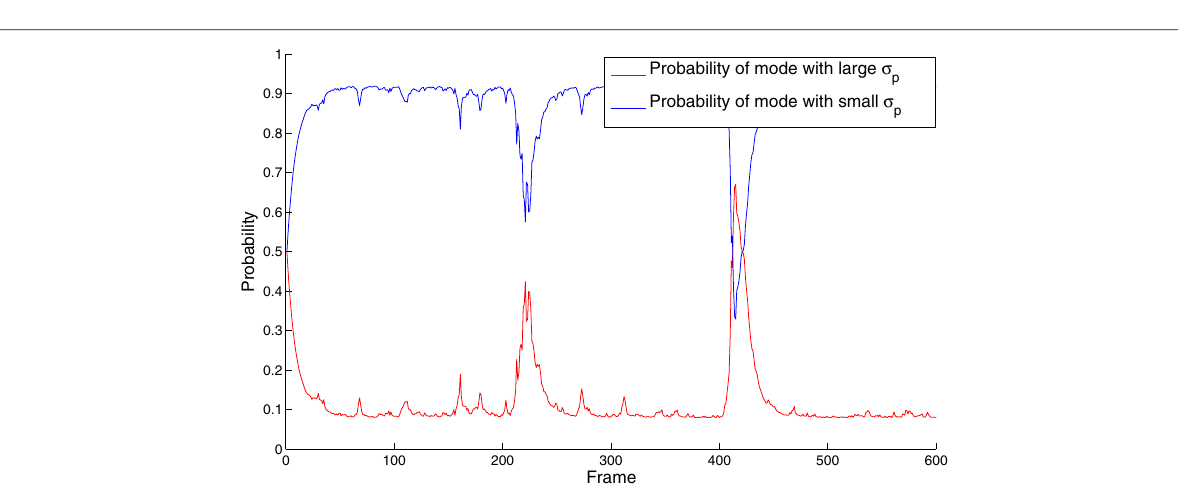
Fig. 5 Changing of mode